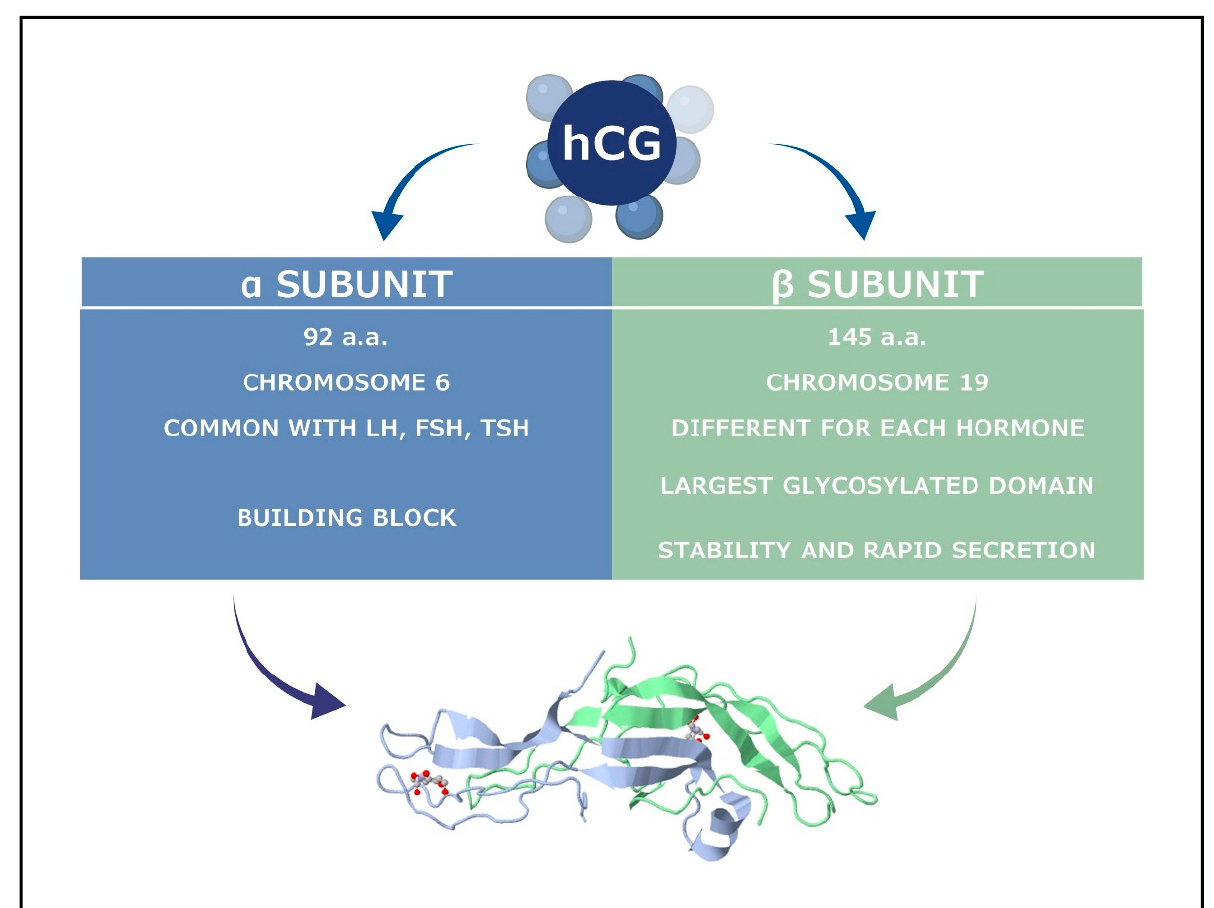
Figure 1. Structure of hCG at 2.6 angstrom resolution from MAD analysis of the selenomethionyl protein (JSMol Viewer: modern web app for 3D visualization and analysis of large biomolecular structures, RCSB PDB, doi: 10.1016/s0969-2126(00)00054-x. PMID: 7922031). In blue, the α subunit and in green, the β subunit.